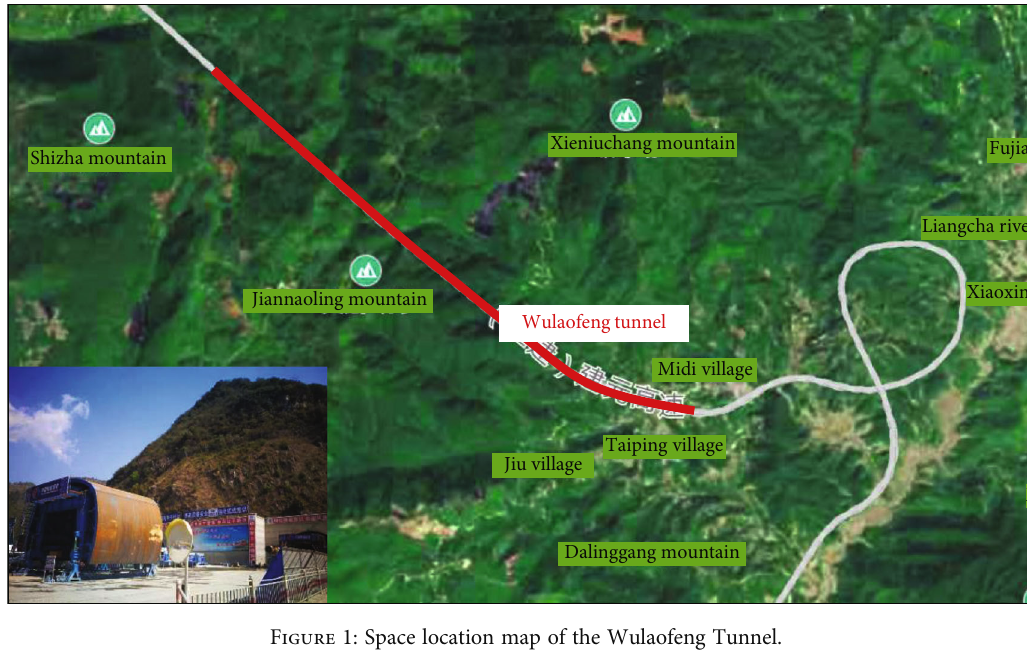
Figure 1: Space location map of the Wulaofeng Tunnel.